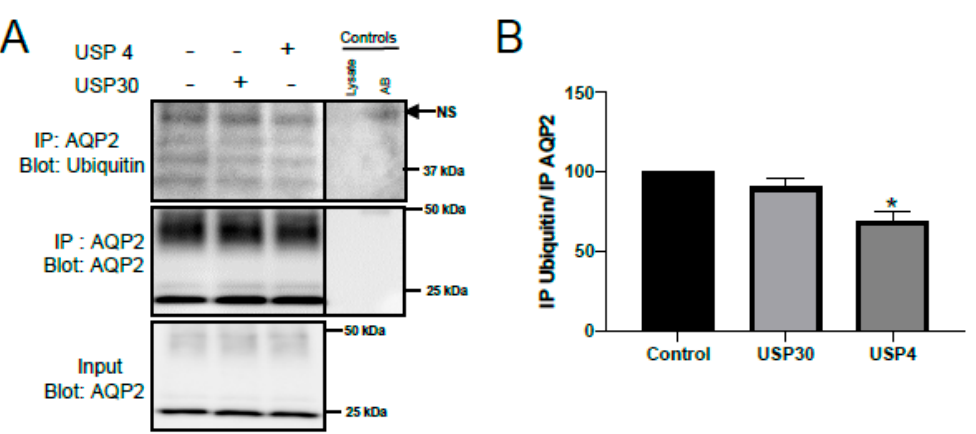
Figure 3. USP4 deubiquitylates AQP2 in vitro. mpkCCD14 cells were grown in the presence